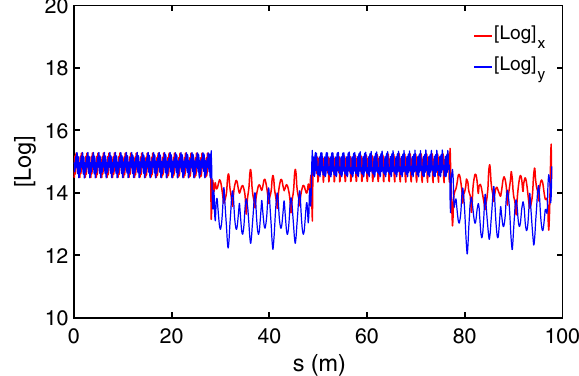
FIG. 1. Numerical values of the Coulomb log factors ½ Log (cid:2) along s in a recirculating accelerator beamline. This quantities are defined in Eq. (5).